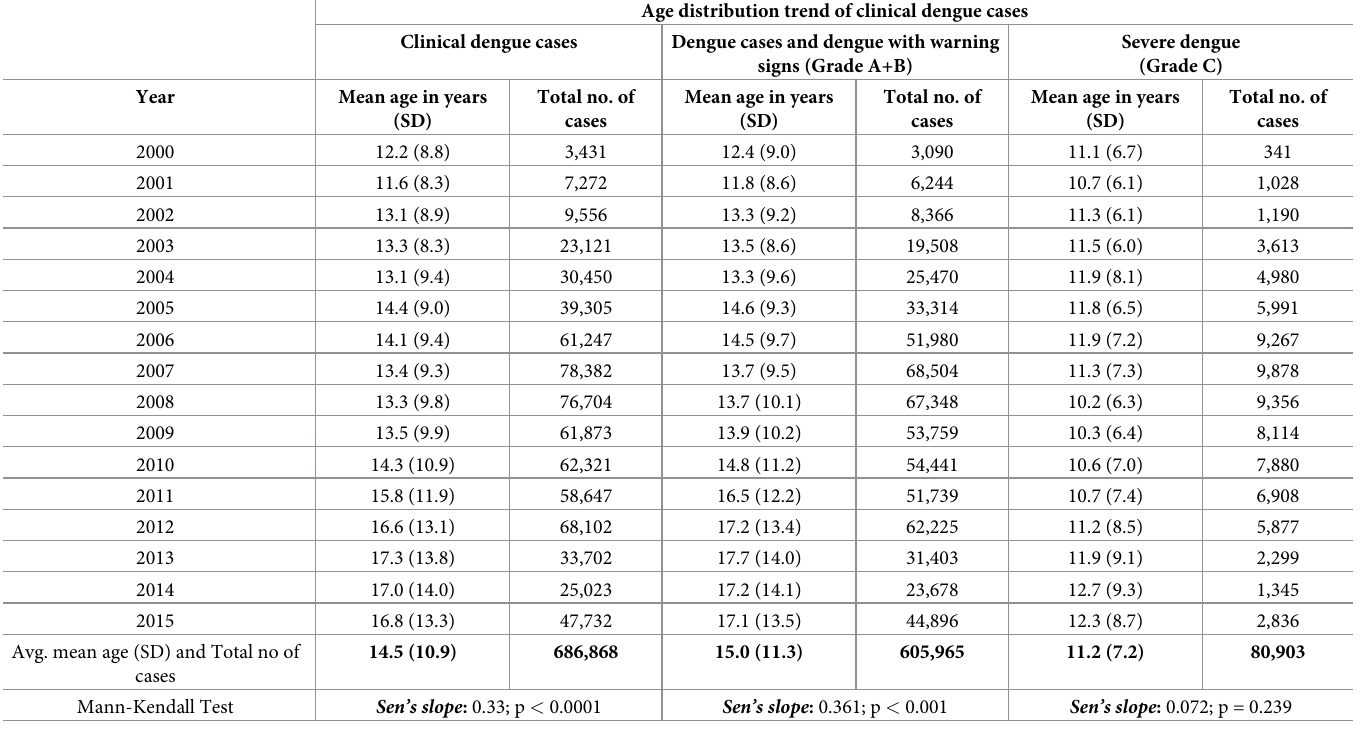
Table 1. Age distribution trend of clinical dengue cases, dengue cases and dengue with warning signs (Grade A+B), and severe dengue (Grade